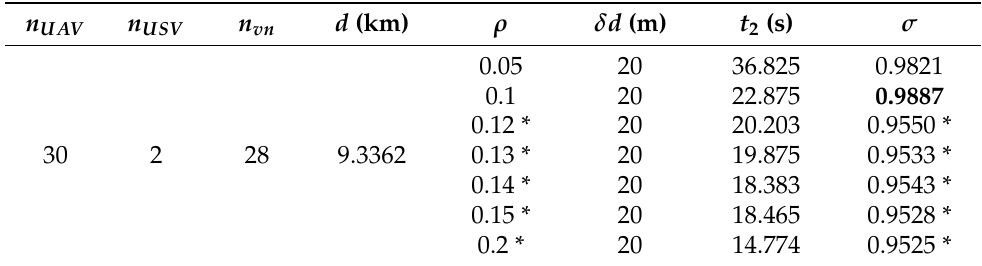
Table 12. Algorithm results: execution time (after time execution improvement) and performance indicator σ , nt = 3, LB = 92 dB, d = 9.3362 km.